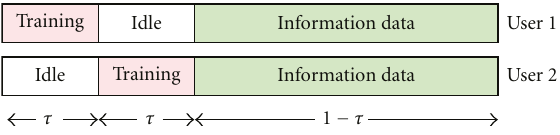
Figure 1: Illustration of the hybrid ALOHA slot structure for M = 2, in the case that two users ( N = 2) transmit their training sequences at nonoverlapping pilot